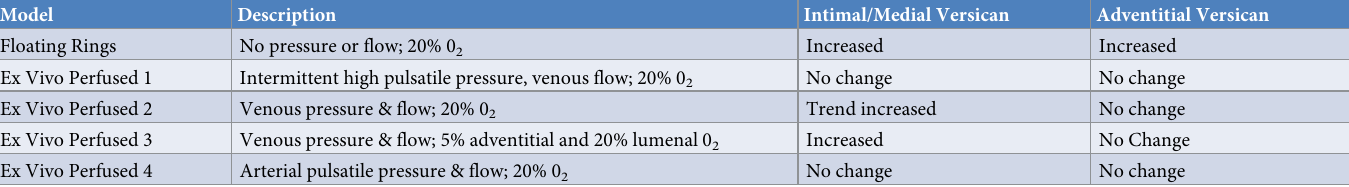
Table 4. Versican changes in different ex vivo vein graft models.